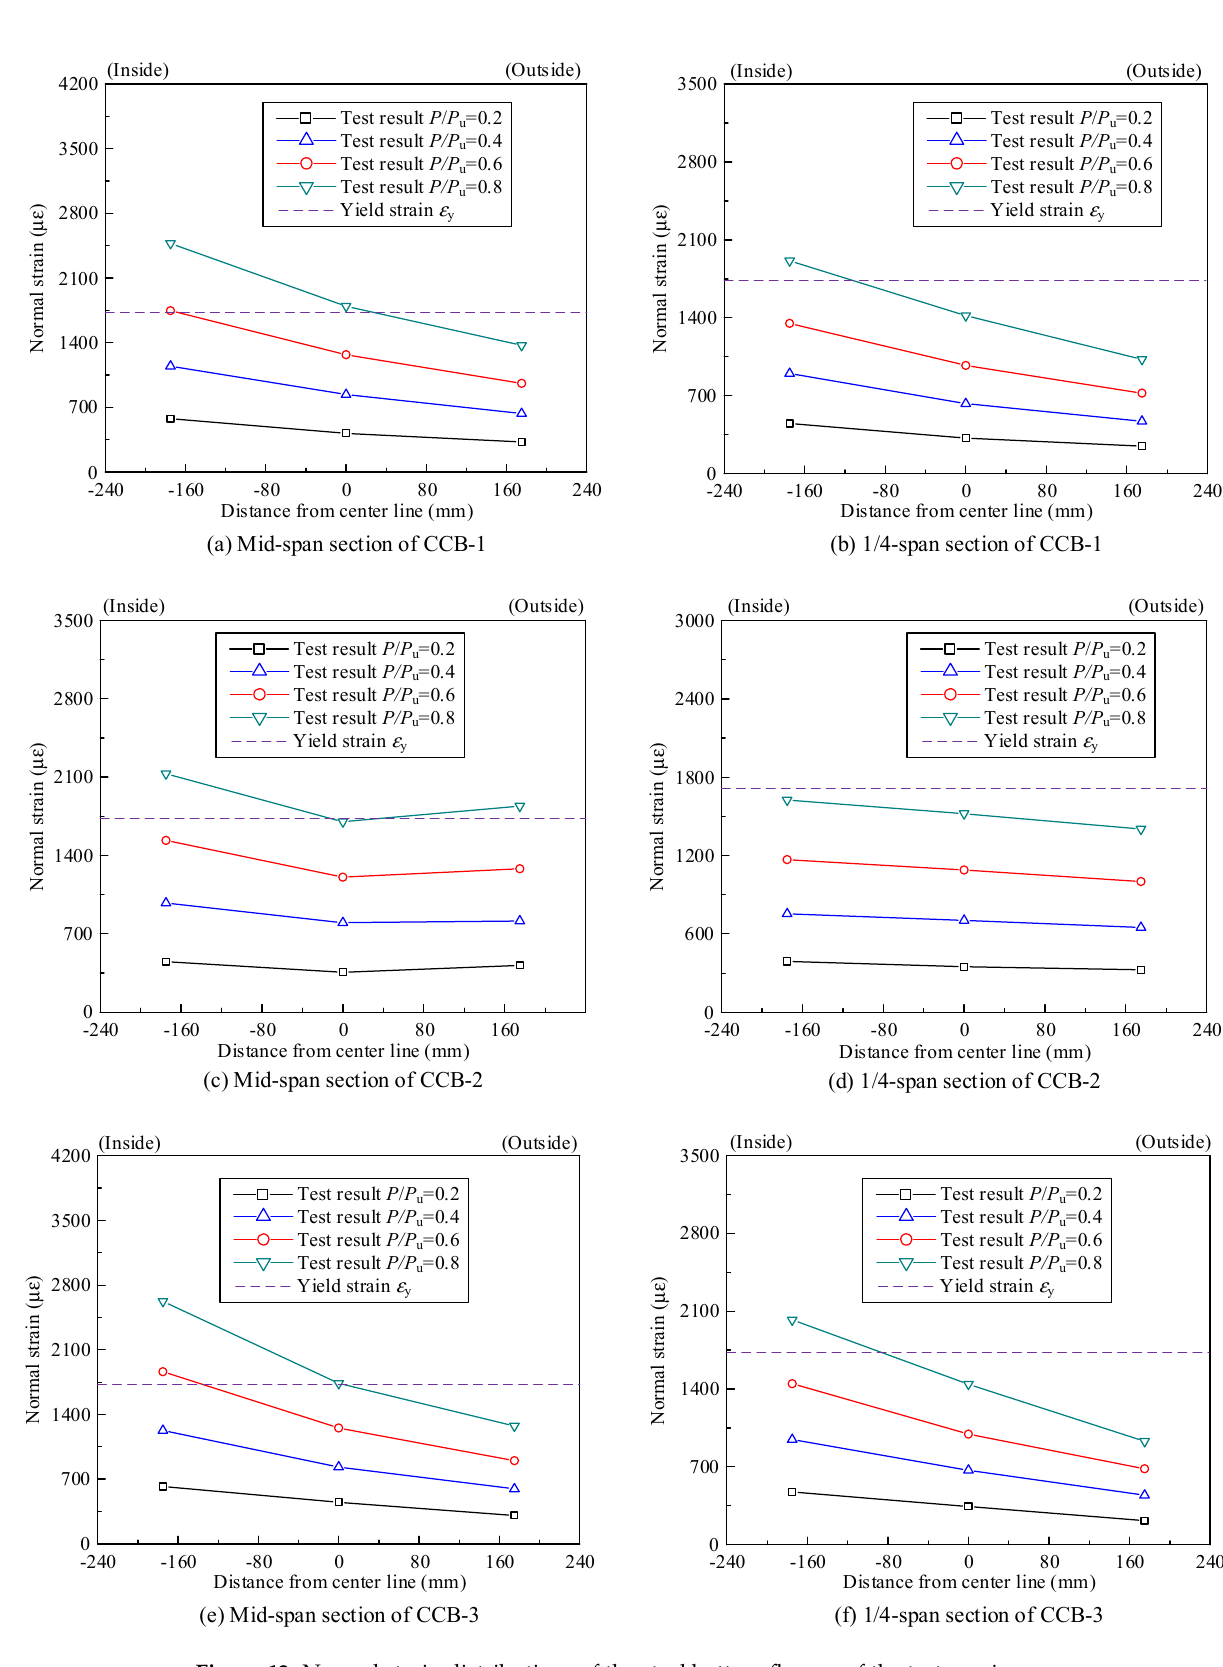
Figure 12. Normal strain distributions of the steel bottom flanges of the test specimens. Figure 13 gives the normal strain distributions of the steel webs of CCB-1–CCB-3 at the midspan sections and the 1/4-span sections. The vertical coordinate 0 in the figure